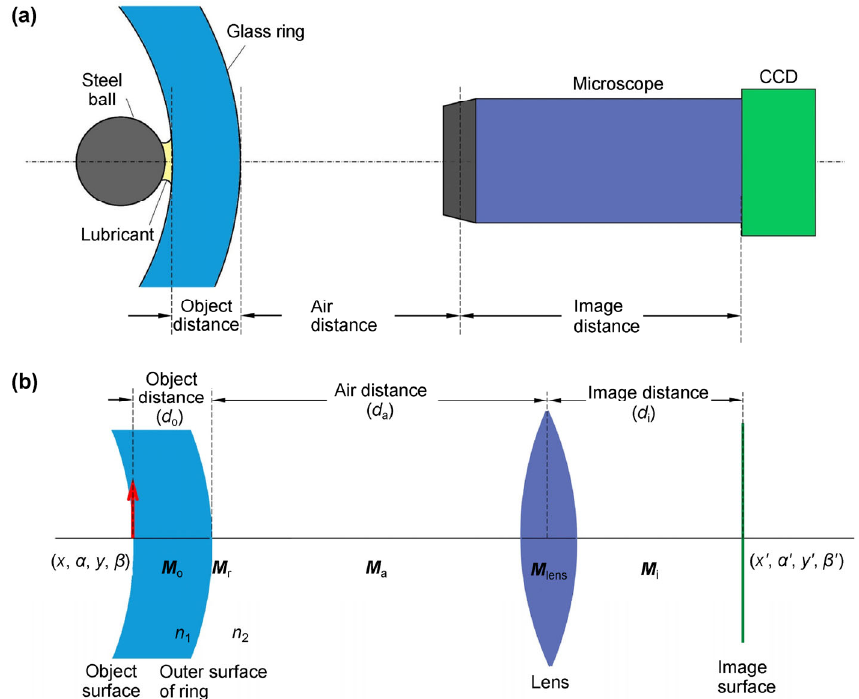
Fig. 4 Optical system of the ball-on-ring test